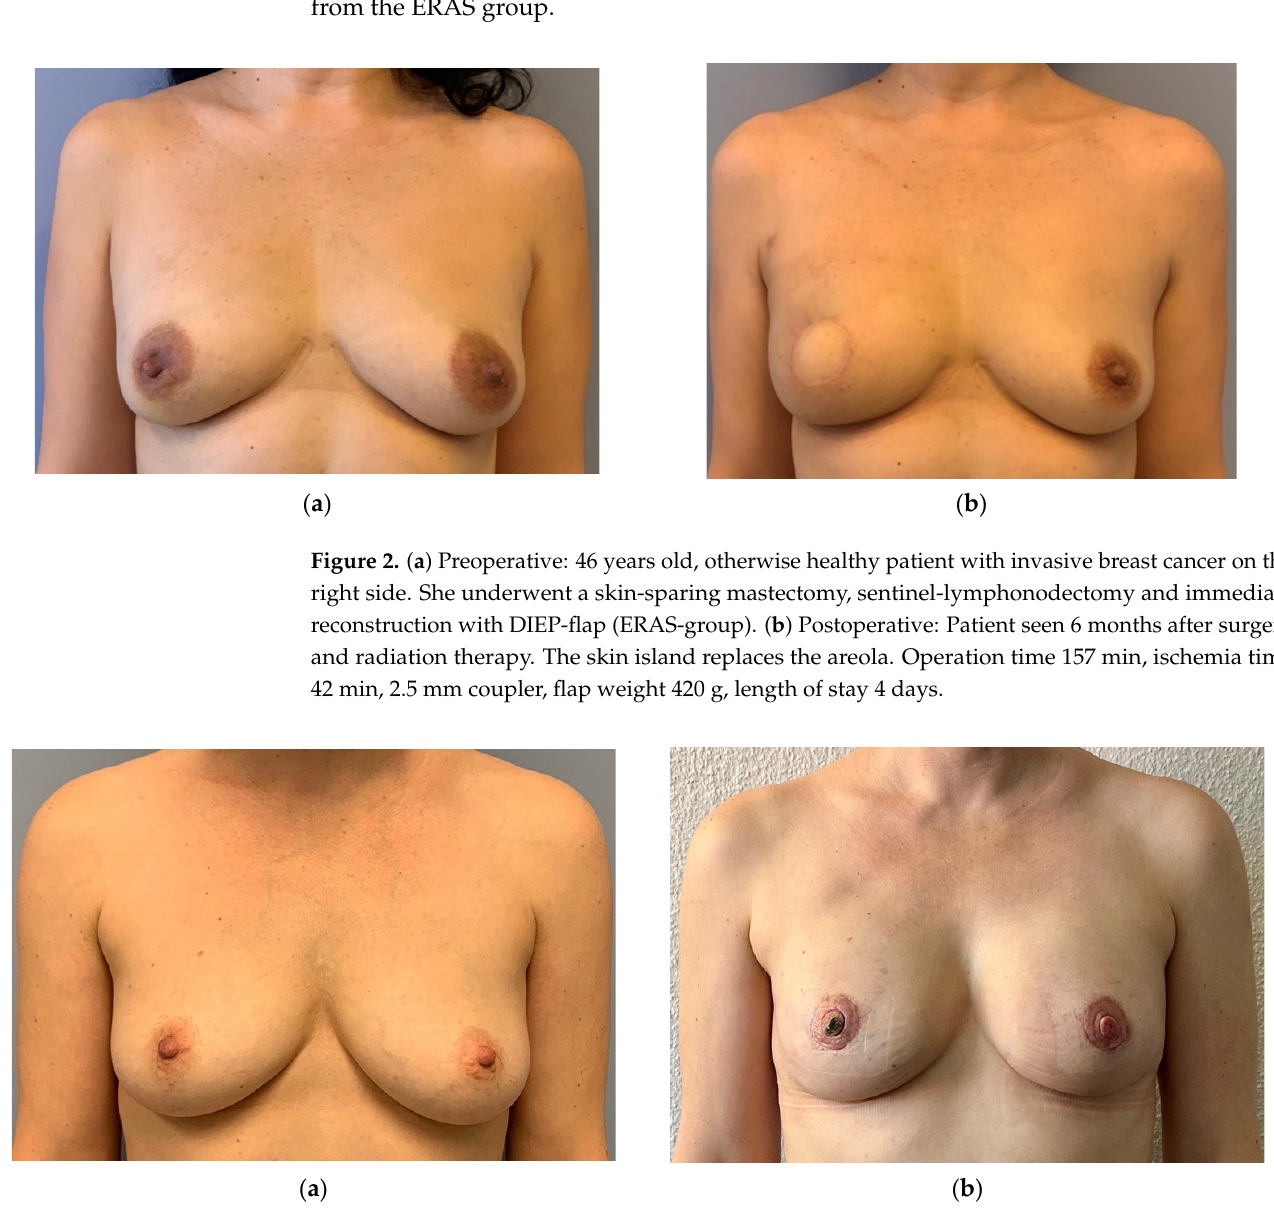
Figure 3. ( a ) Preoperative: 43 years old, otherwise healthy patient received a bilateral prophylactic nipple-sparing mastectomy and immediate reconstruction with DIEP-flap (ERAS-group). ( b ) Postop- erative: Patient 6 weeks after surgery. No monitor island was placed, small nipple necrosis on the right side was treated conservatively. Operation time 348 min; ischemia time 37 min right, 44 min left; 2.0 mm coupler right, 2.5 mm left; flap weight 290 g right, 285 g left; length of stay 5